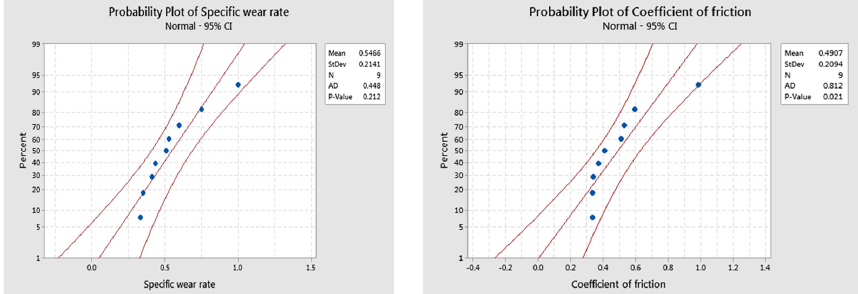
Figure 4. Plots of outlier and normal probability for the proposed GRA—PCA method.